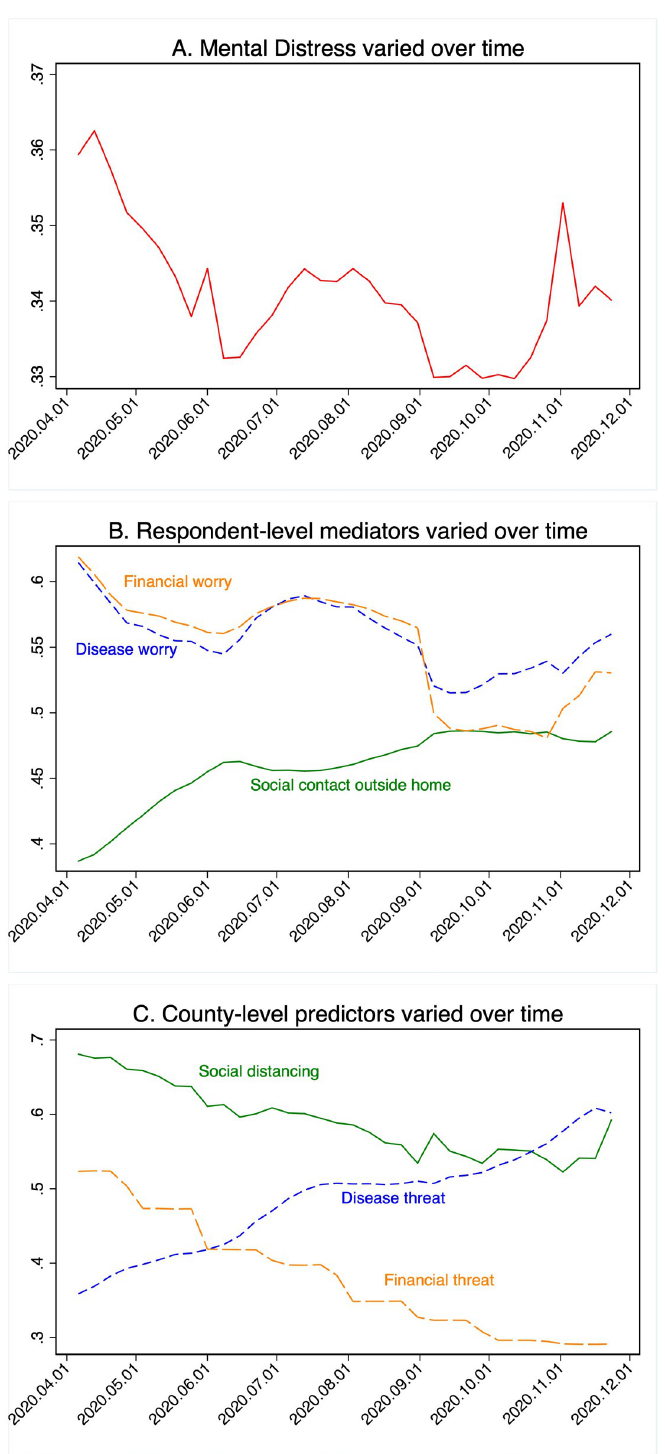
Fig 2. Mean level of the variables of interest over time. (A) Self-reported mental distress. (B) Respondent-level endogenous mediating variables (disease and financial worries and social contact). (C) County-level exogenous predictor variables (disease and financially-related stressors and social distancing). All variables were normalized to the range of 0 to 1 before averaging. Averages vary over both location and time.